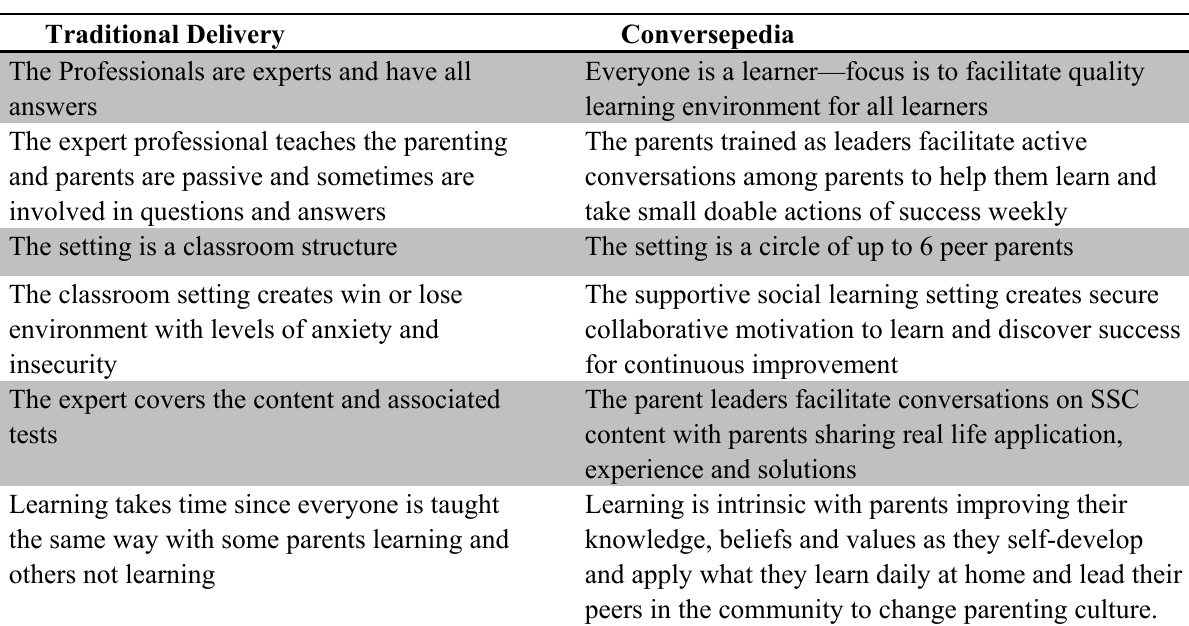
Table 1. Comparison of Parenting Curriculum Delivered through Traditional method vs.